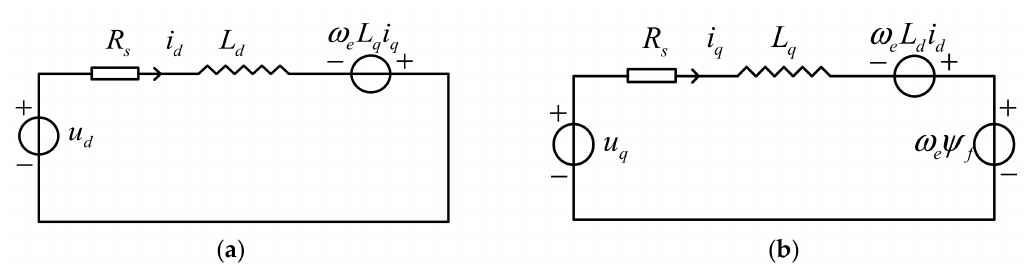
Figure 4. Equivalent circuit of PMSG in d / q-axis. ( a ) d-axis circuit; ( b ) q-axis circuit.